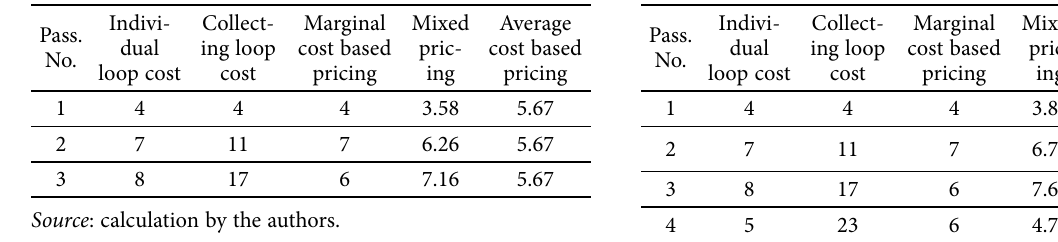
Table 4. Cost table for the pricing systems in case No.